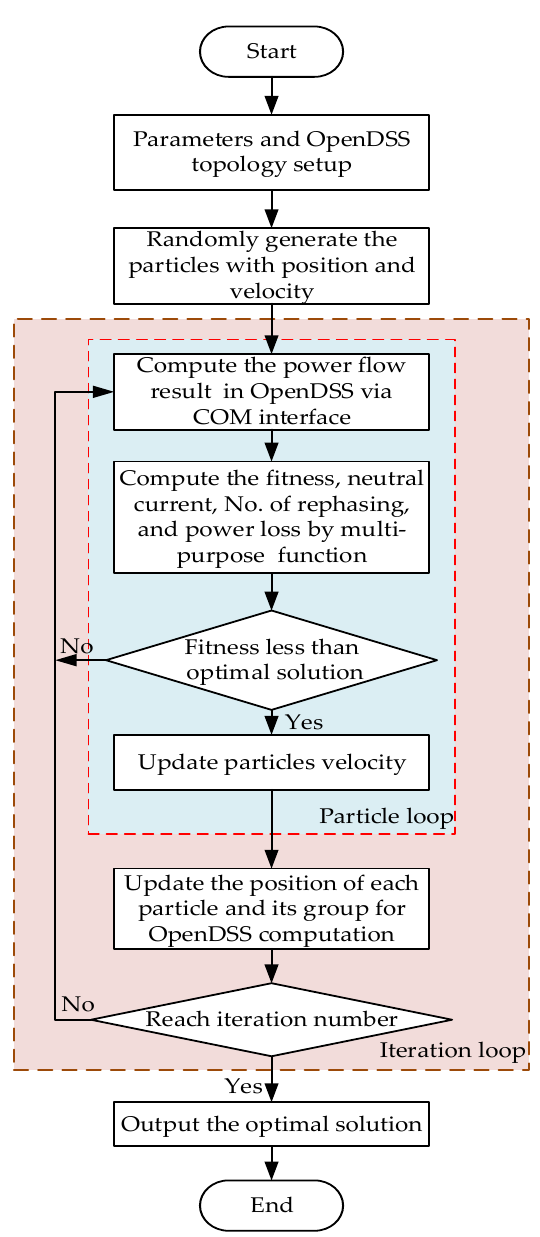
Figure 6. PSO solution flow chart.